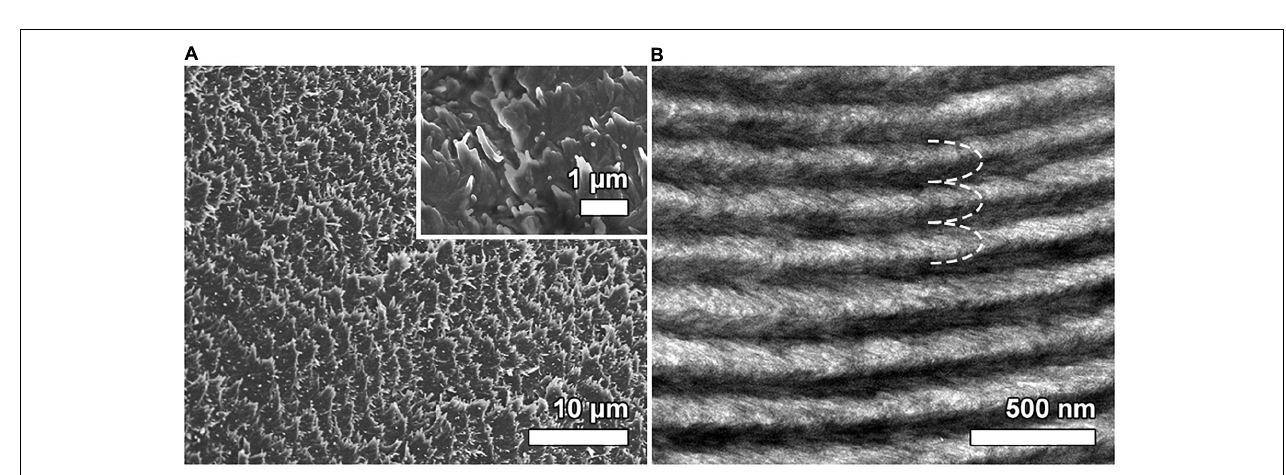
FIGURE 1 | POM image of sample CS1-Rh (A) and CS4-Rh (B) between crossed polarizers.